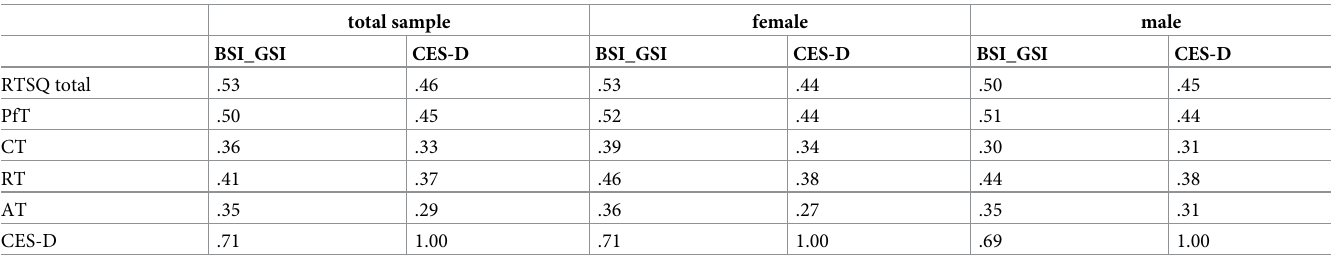
Table 7. Correlations between RTSQ, BSI and CES-D scores (Study 1).